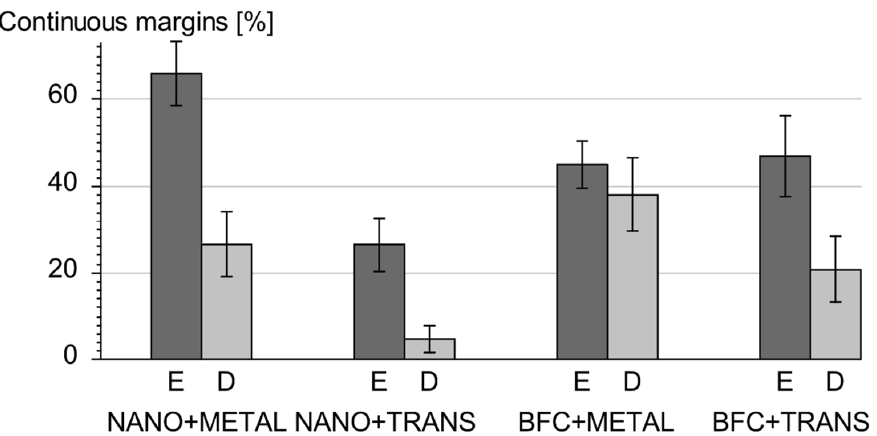
Figure 5. Mean percentages with standard deviation of continuous margins in enamel (E) and dentin (D) in all groups; NANO = Tetric EvoCeram; BFC = Tetric EvoCeram Bulk Fill; METAL = metal matrix band, TRANS = transparent matrix band. Table 2. Percentages of continuous margins in enamel and dentin ( n = 40). Continuous Margins [%]